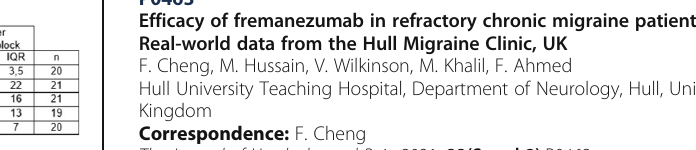
Fig. 1 (abstract P0461). See text for description